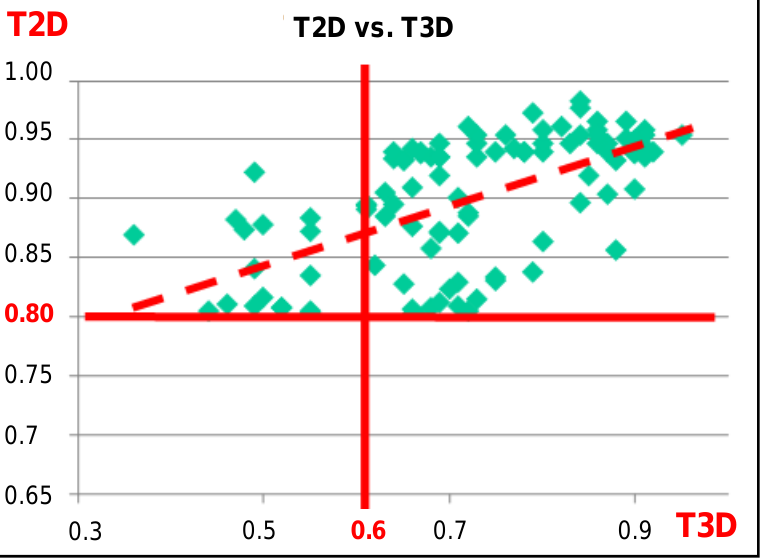
Figure 4. Correlation between T2D and T3D values of the compounds (104) selected for the second round screening.